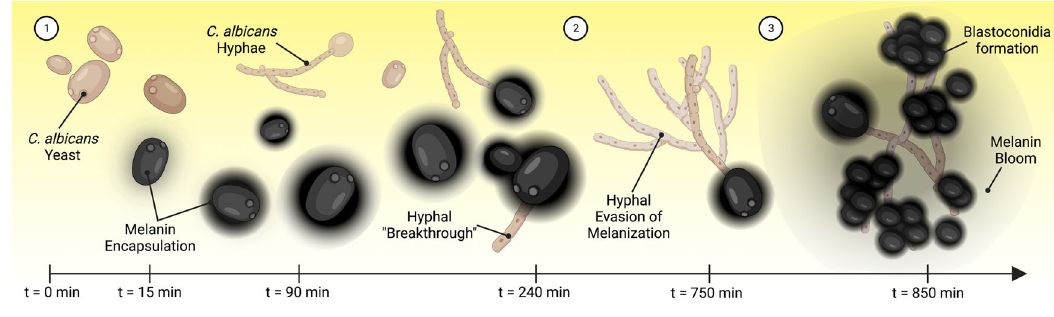
Fig. 7 Overview of the growth of C. albicans within G. mellonella and the fungus ’ interaction with the melanization immune response. (1) Within 15 min of exposure to hemolymph, immune melanin forms around the C. albicans yeast. Following melanin encapsulation, ~23% of yeast form a germ tube that grows and escapes the melanin encapsulation. Non-melanin-encapsulated yeast form germ tubes faster and more frequently. (2) Hyphal growth continues with minimal melanin encapsulation occurring on hyphae. (3) Yeast (blastoconidia) begin to form on hyphae after 12 – 16 h, which triggers a large-scale bloom in the